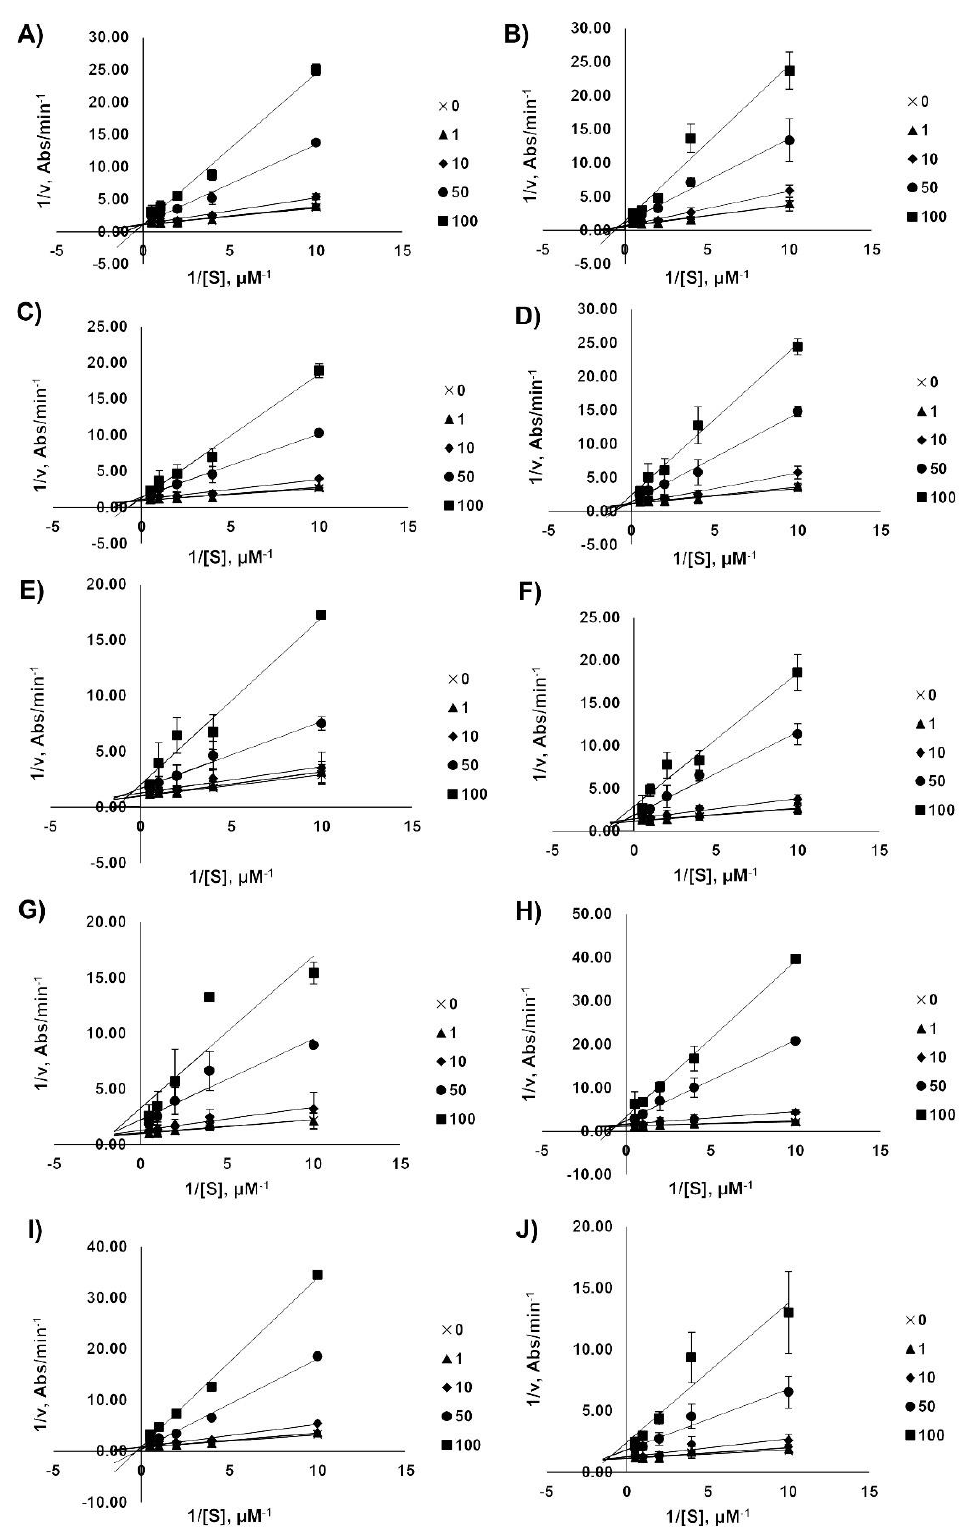
Figure 4. Lineweaver–Burk plots for the inhibition of AChE by acridones N-methylatalaphylline ( A ), atalaphylline ( B ), N-methylatalaphyllinine ( C ), atalaphyllinine ( D ), N-methylcycloatalaphylline A ( E ), citrusinine II ( F ), citrusinine I ( G ), glycosparvarine ( H ), citruscridone ( I ), and buxifoliadine C ( J ). The absorbance was measured by UV spectroscopy at the wavelength of 405